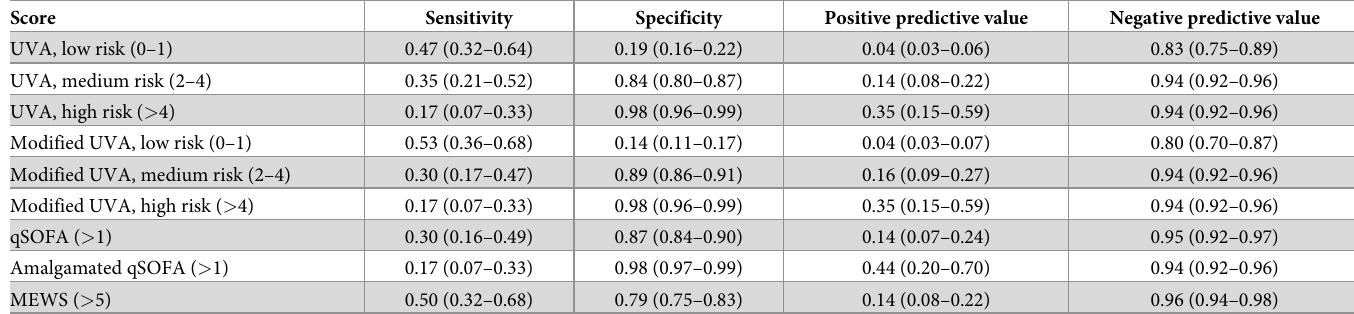
Table 4. A comparison of the sensitivity, specificity, positive predictive value, and negative predictive value including 95% confidence intervals in parentheses for in-hospital mortality for adult patients admitted to hospital with acute infection in Gitwe, Rwanda according to different cut-offs for the UVA score, Modified UVA score, qSOFA score, Amalgamated qSOFA score, and